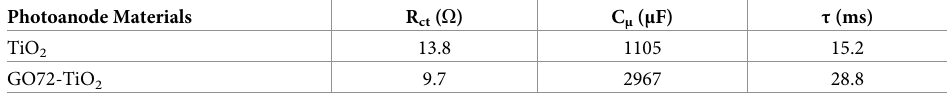
Table 6. Summaries of electron lifetime of TiO 2 -based and GO-decorated photoanode. Photoanode Materials